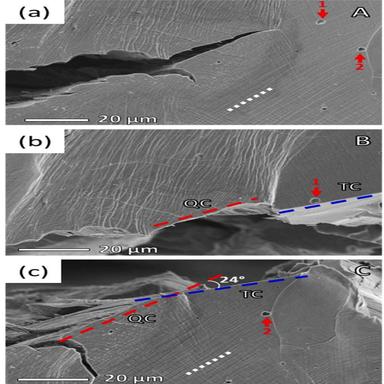
The SEM images demonstrating the specific region of the side surface of the pure iron specimen after the first- – (a) and second-step loadings – (b, c). The QC crack being arrested after the first-step loading (a) was extended by TC cracking during the second-step loading (b, c) The red and blue dashed lines indicate the parts of the crack associated with QC and TC fracture modes respectively. The white dotted lines in (a) and (c) indicate the orientation of the specific slip lines. The non-metallic inclusi